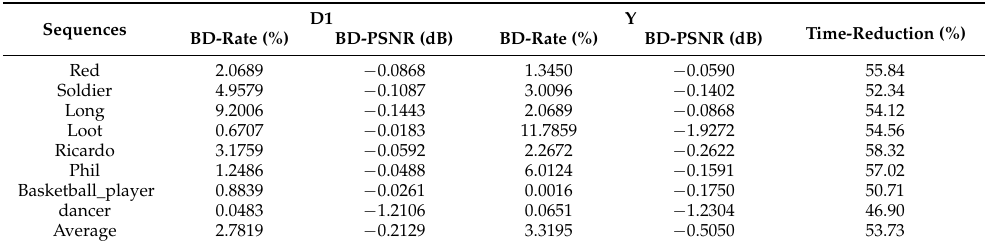
Table 1. The BD-rate, BD-PSNR, and runtime for V-PCC with voxel size of 4 in comparison with V-PCC with voxel size of